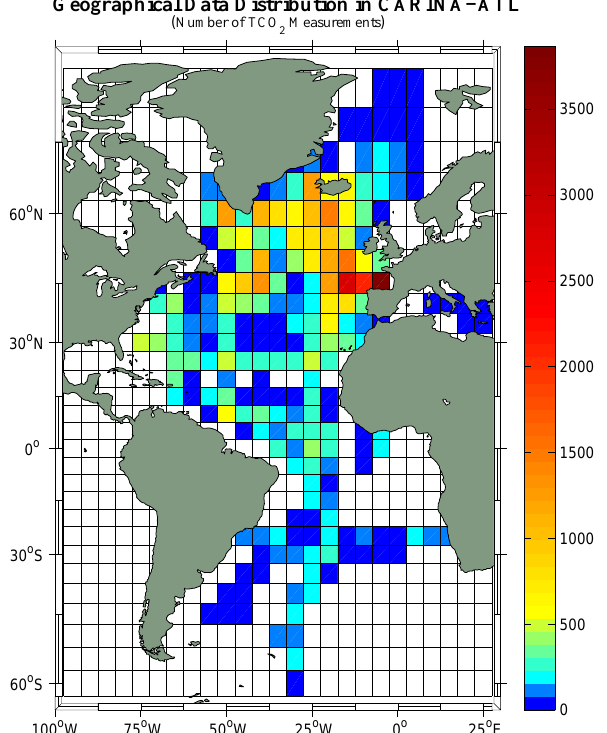
Figure 2. Geographical TCO 2 data distribution in the CARINA Atlantic data set. Each square is a 5 ◦ × 5 ◦ bin and its color represents the number of TCO 2 measurements made in that bin. Bins with no TCO 2 measurements are blanked.